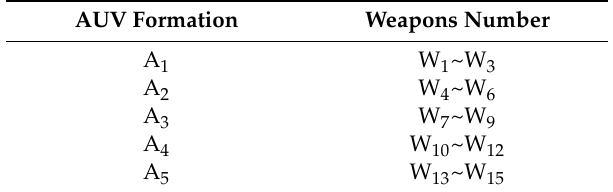
Table 1. Number of autonomous underwater vehicle (AUV) formation armed with weapons.